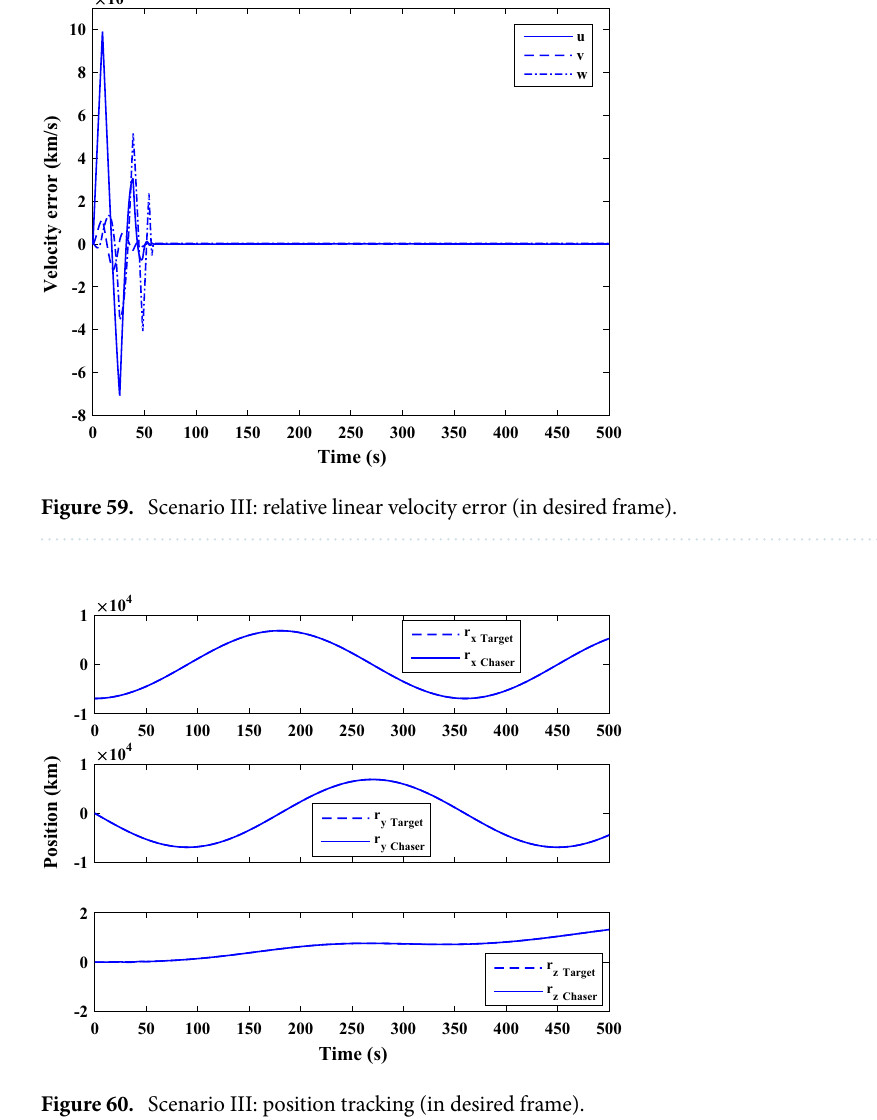
Figure 60. Scenario III: position tracking (in desired